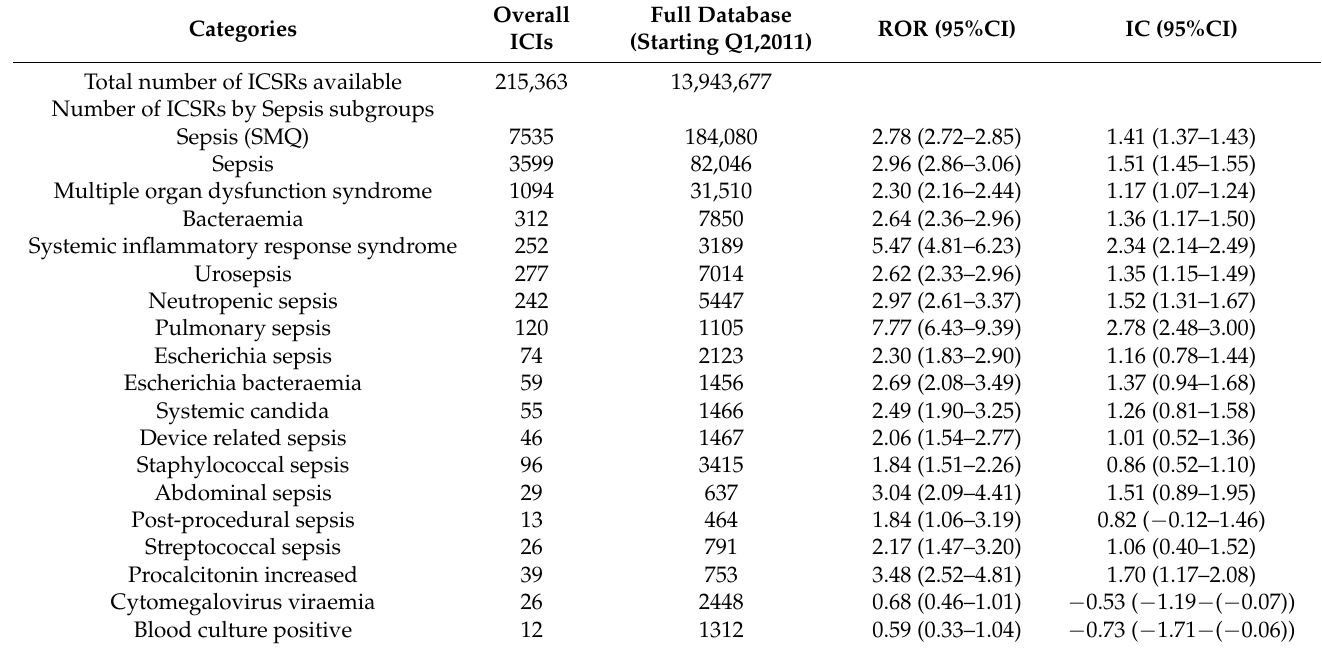
Table 1. Checkpoint inhibitor-related sepsis reported with ICIs versus those reported in the full database from FAERS, from Q1, 2011 to Q3,